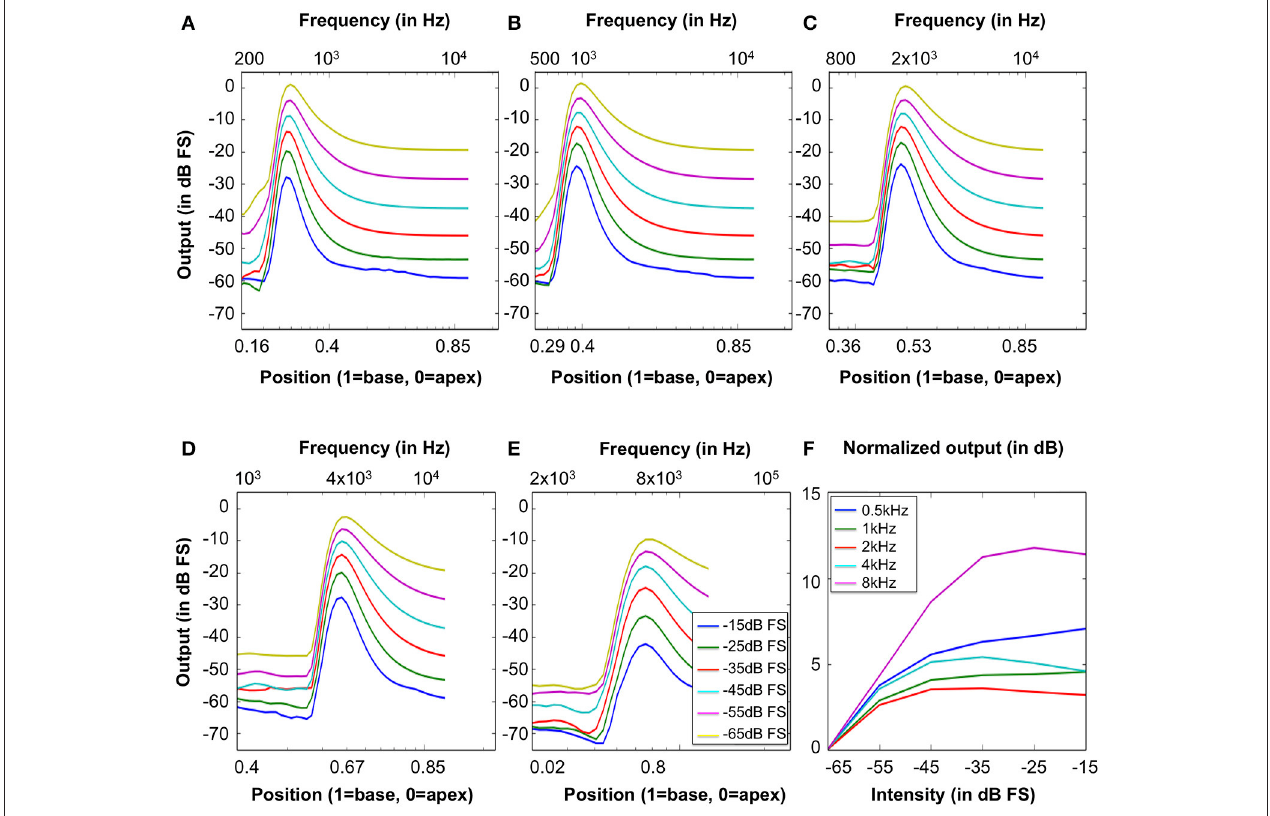
FIGURE 11 | Excitation patterns calculated as the RMS output signal of the 70 CAR-FAC channels in response to tones at (A) 0.5kHz, (B) 1kHz, (C) 2kHz, (D) 4kHz, and (E) 8kHz with intensities ranging from -65 dB FS to -15 dB FS in steps of 10 dB FS. The x-axis shows both the frequency and the position-frequency location calculated from Equation (9). (F) The normalized nonlinear response growth of the system to the tones of 0.5, 1, 2, 4, and 8kHz (squared-cosine rise and decay time of 10ms) with intensities between -65 dB FS and -15 dB FS in steps of 10 dB